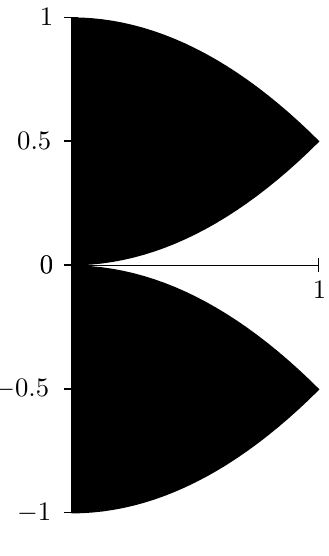
Figure 3. Graph of F ∪